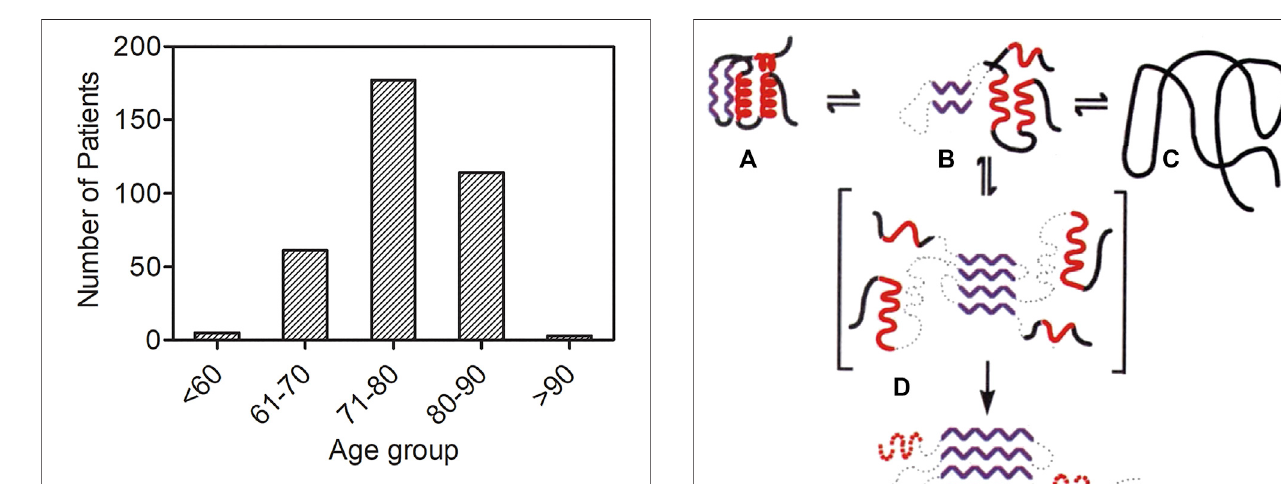
FIGURE 5 | Number of patients diagnosed, ante mortem, for wild type ATTR. Data shown are based on a retrospective review of patients diagnosed with wild type ATTR at the Mayo Clinic through 2013 with the purpose of studying the natural history of the disease (Grogan et al., 2016).